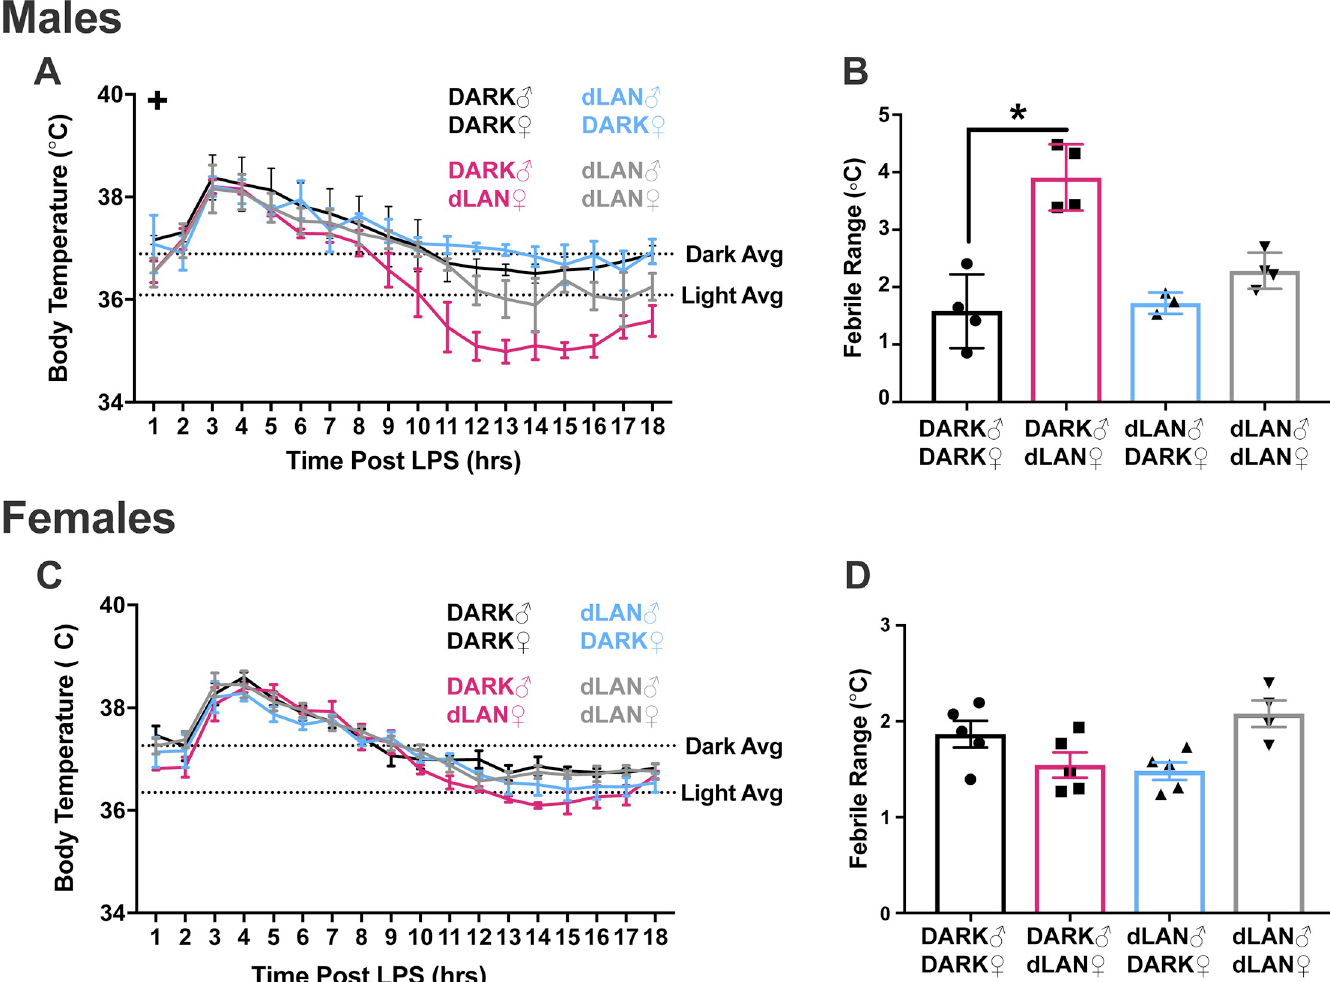
Fig 2. Male offspring of dams exposed to preconception dLAN enhanced magnitude of febrile responses. Body temperature from 0 to 18 hours post-LPS and febrile range in male (A,B) and female (C,D) offspring. Horizontal dashed lines represent mean baseline body temperature during the dark and light phase. N = 3-5/group/sex; error bars represent SEM. +, P < 0.05 Dark-dLAN vs Dark-Dark and dLAN-dLAN; � , P < 0.05 Dark-dLAN vs Dark-Dark.